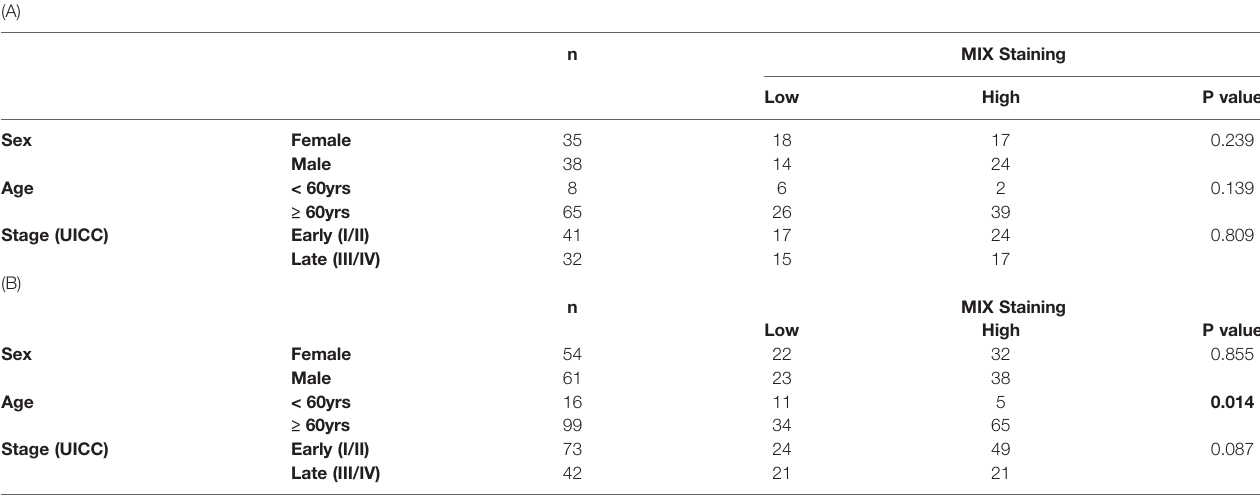
Numbers of tumor tissues from non-treated patients included at 5 years (A) and 7 years (B) of OS, for which there is a MIX-Low staining or a MIX-High staining, according to clinical and pathological data, i.e., gender, age and stage, were indicated. The association between MIX staining and clinicopathological characteristics of patients was evaluated by